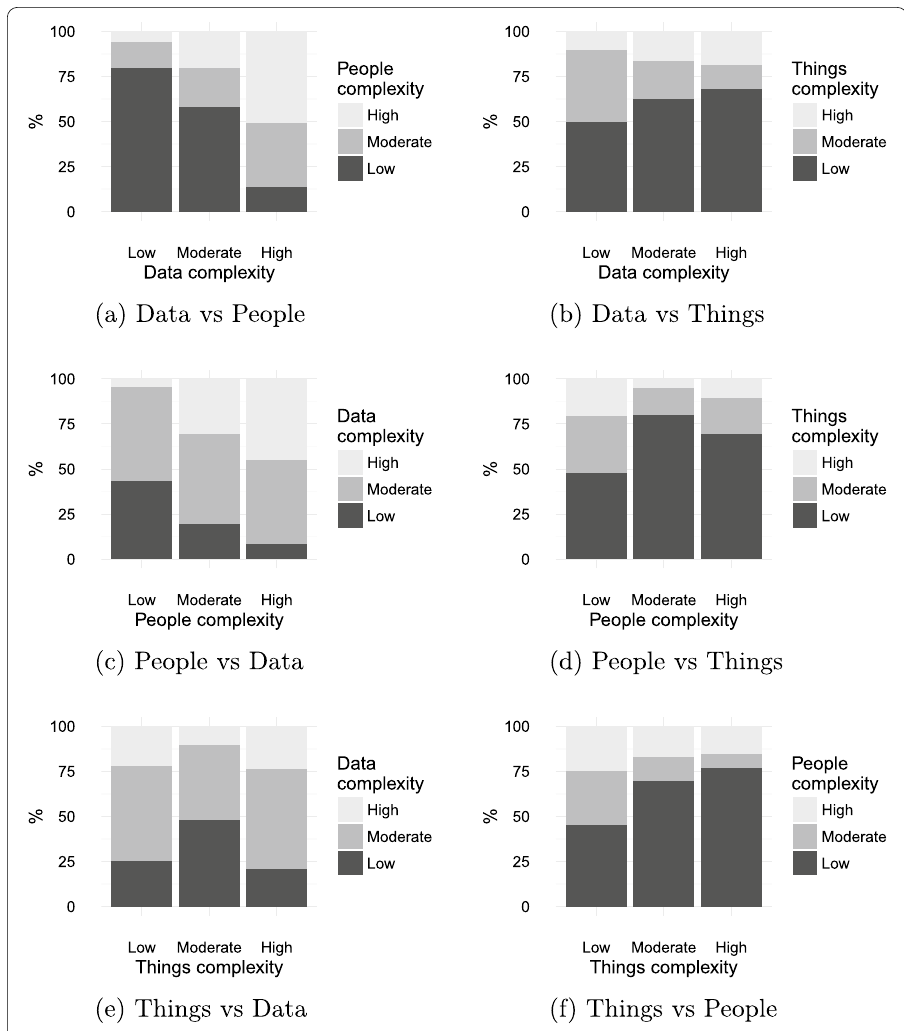
Fig. 7 Relationship between pairs of occupational complexity dimensions. total data (Source: PIAAC 2012, DOT index, ISCO-08